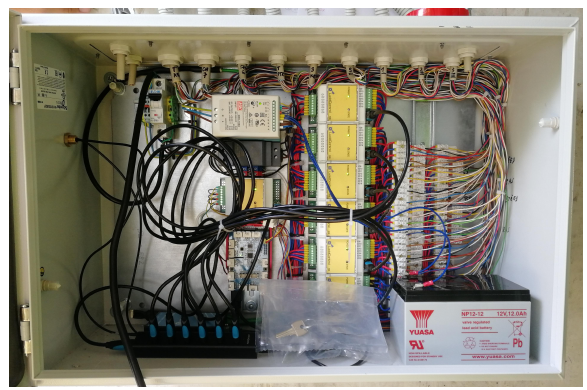
Figure 4. Installed switchboard on-site.